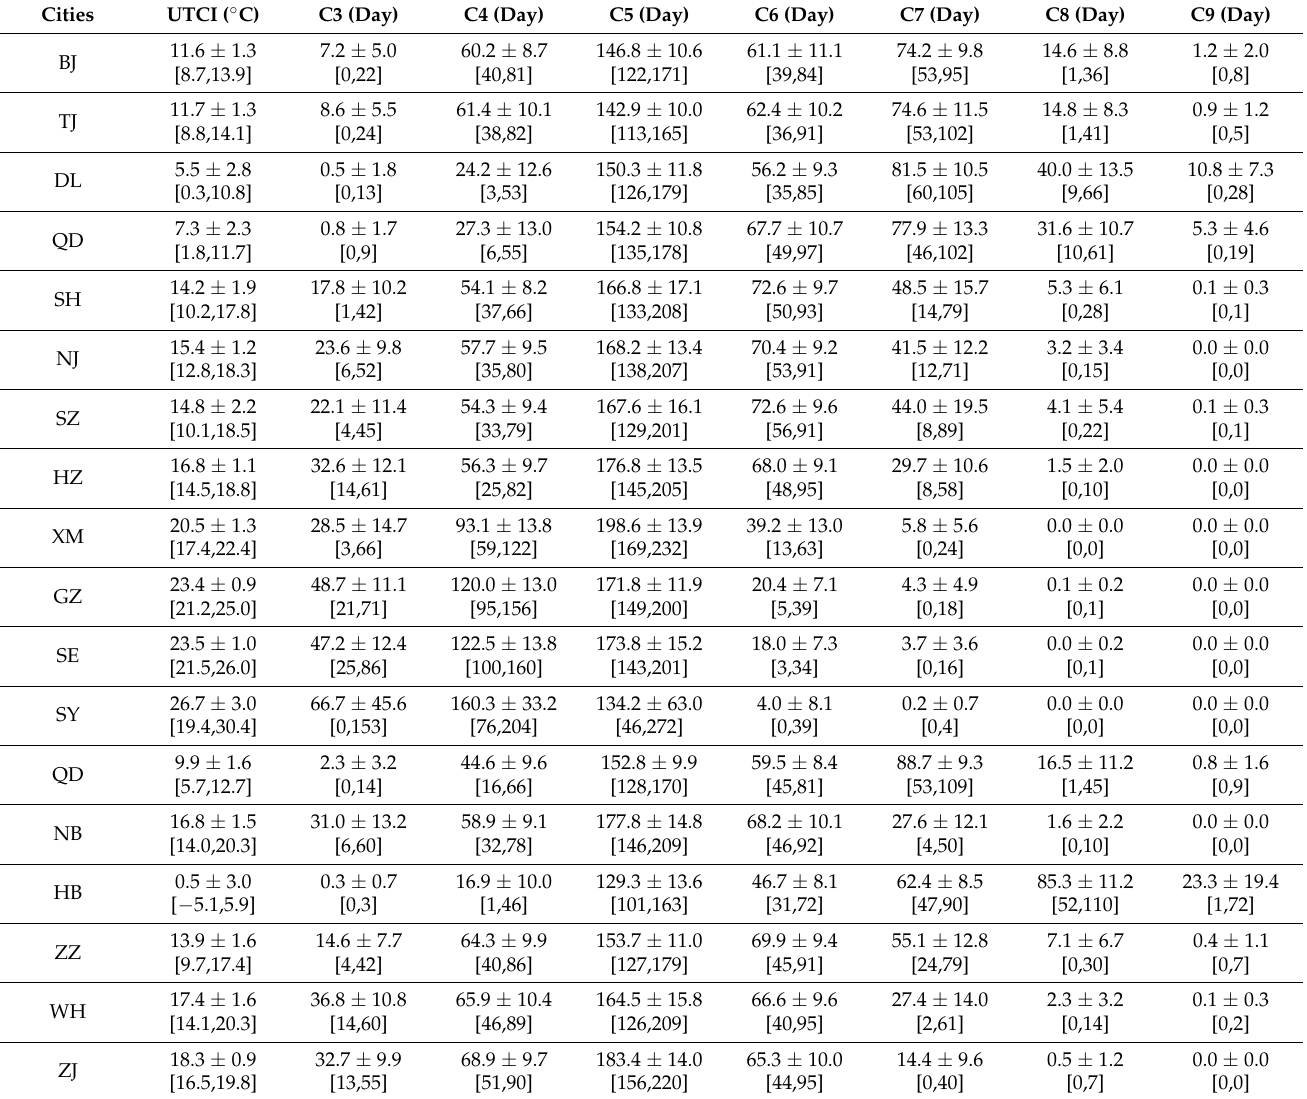
Figure 4. Comparison of the days within each UTCI category calculated by observed radiation (line blue circle) with those by estimated radiation (line with pink triangle). Table 6. Detailed information on UTCI and the yearly days within each category in the large tourism cities of China.